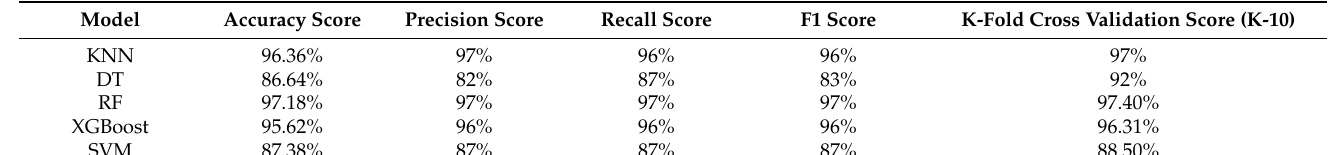
Table 4. Accuracy, precision, recall, F1 and 10-fold cross validation scores.